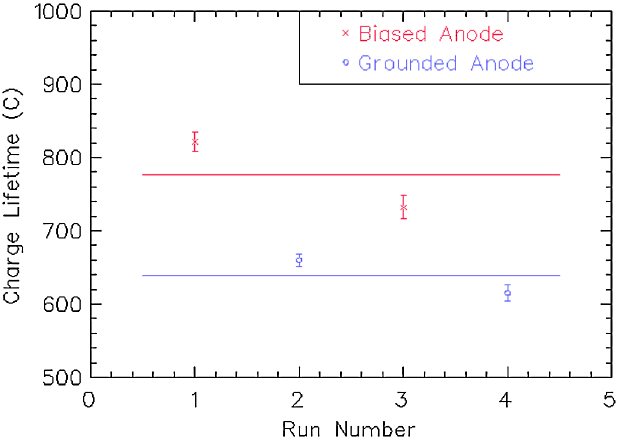
FIG. 13. Photocathode charge lifetime at 2 mA for alternately biased and grounded anode; the average for both the biased and grounded configurations is shown with the horizontal bars. (Note when considering all four data points, there appears to be an overall trend toward reduced charge lifetime, and this may be a result of slight vacuum degradation encountered over the